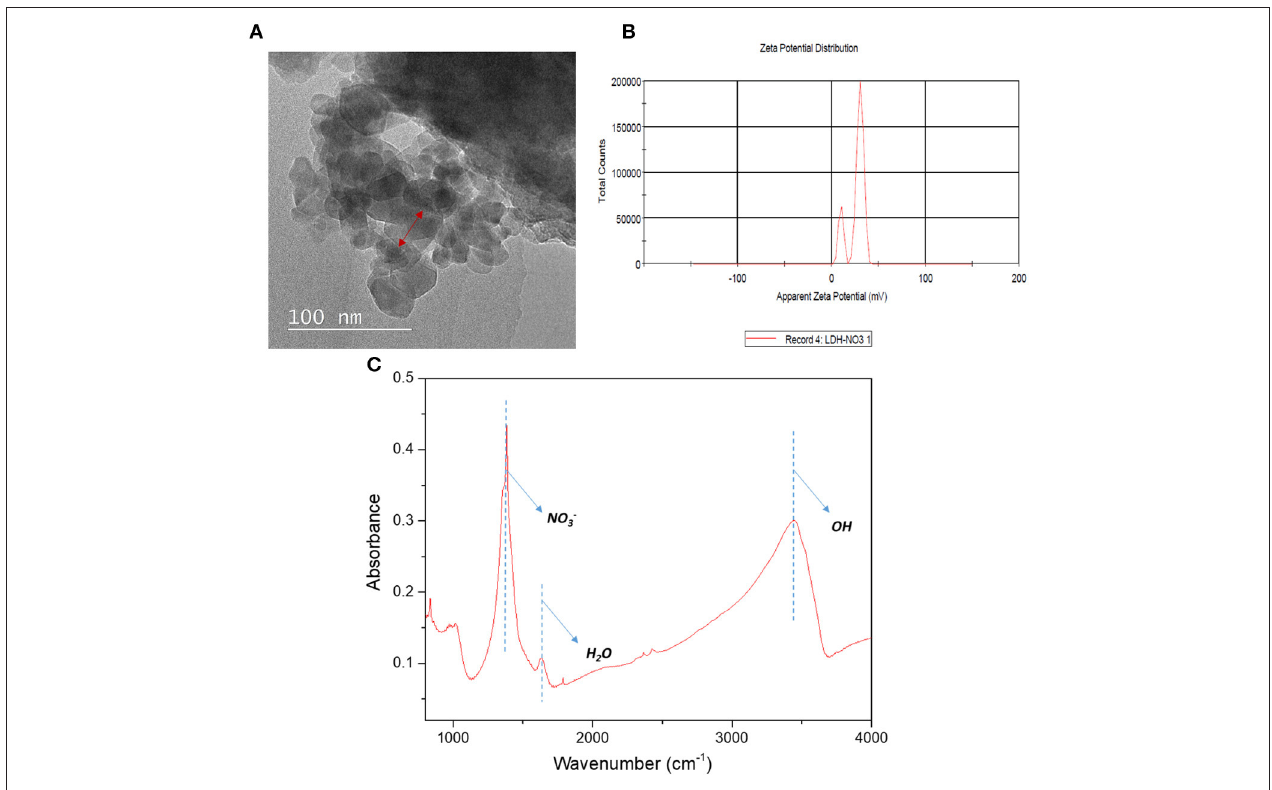
FIGURE 1 | (A) Morphological structures (B) Zeta potential analysis of Cu-Al LDH (C) FTIR analysis of Cu-Al LDH in 4,000–500 cm − 1